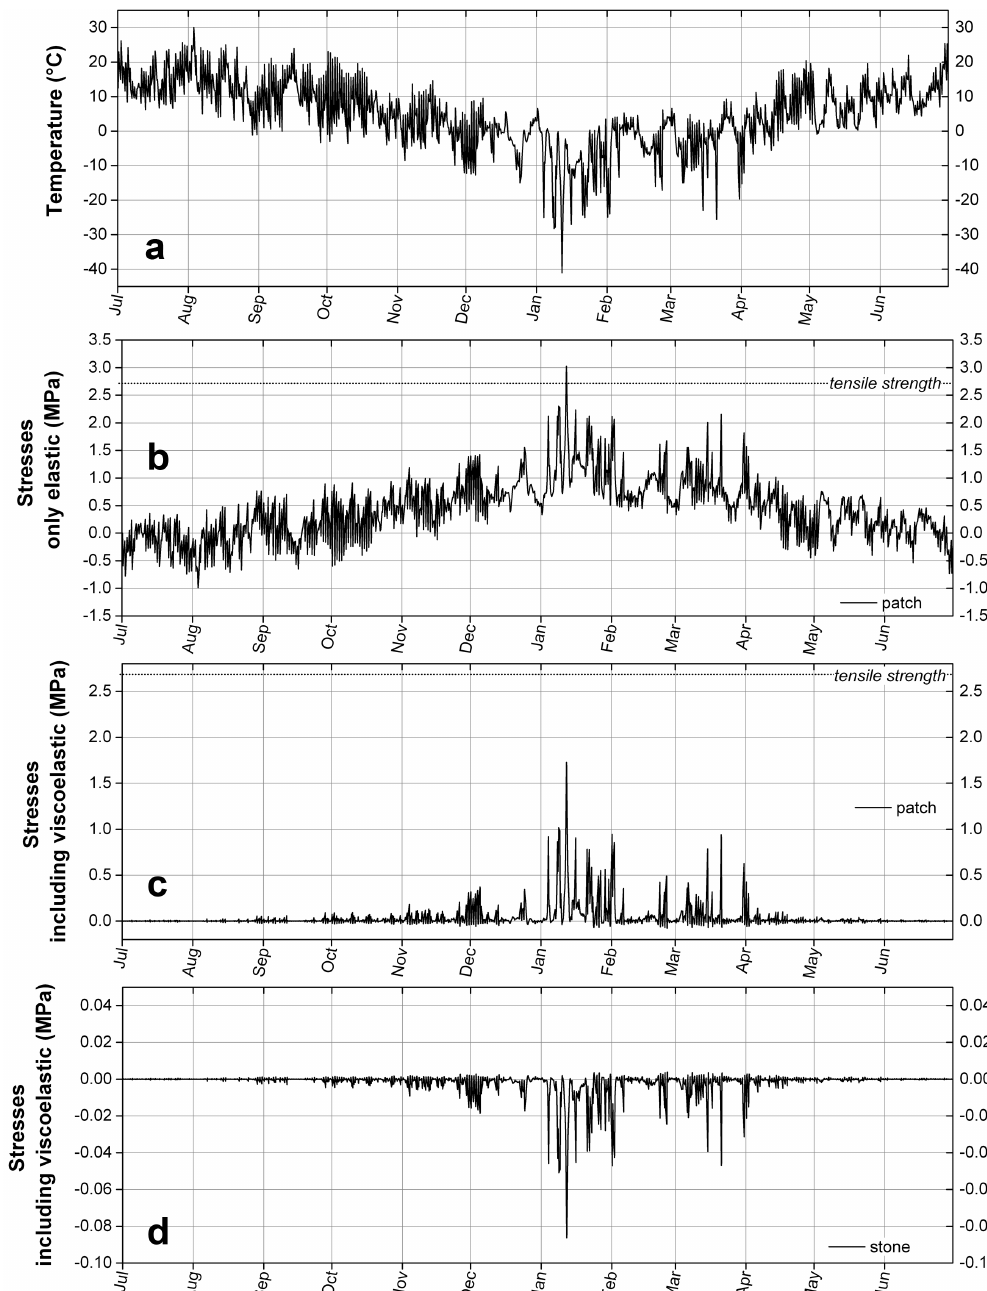
Figure 14. ( a ) Temperature in La Brévine in January 1987; ( b ) Calculation of the thermal stresses in the repair material, without considering its viscoelasticity; ( c ) Calculation of the expected viscoelastic stresses in the repair material; ( d ) Calculation of the thermal stresses in the natural